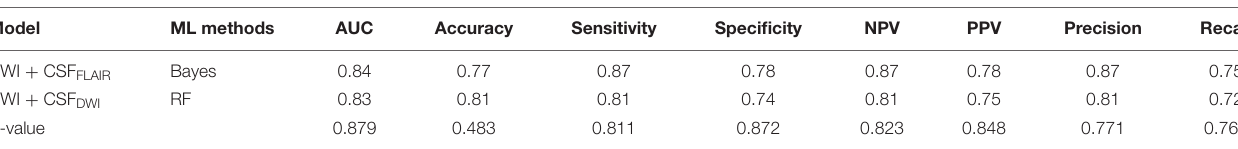
FIGURE 5 | The ROC curves (A) and the precision-recall curves (PRCs) (B) of the Bayes model based on DWI + CSF FLAIR features and the RF model based on DWI + CSF DWI features from external validation for predicting edema after acute stroke. TABLE 3 | The performance metrics of external